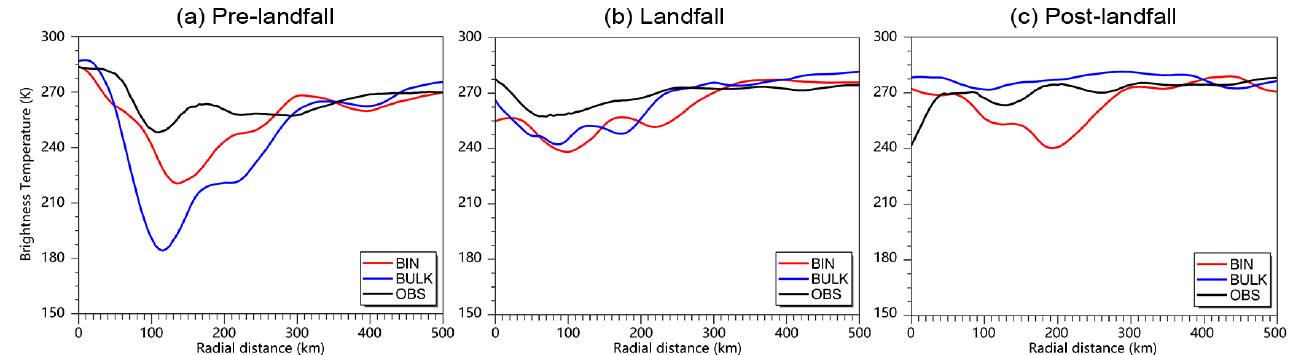
Figure 7. Azimuthal mean brightness temperature (K) distributions of GMI satellite observation and WRF simulations for Typhoon In-Fa (2021) during three different landfall